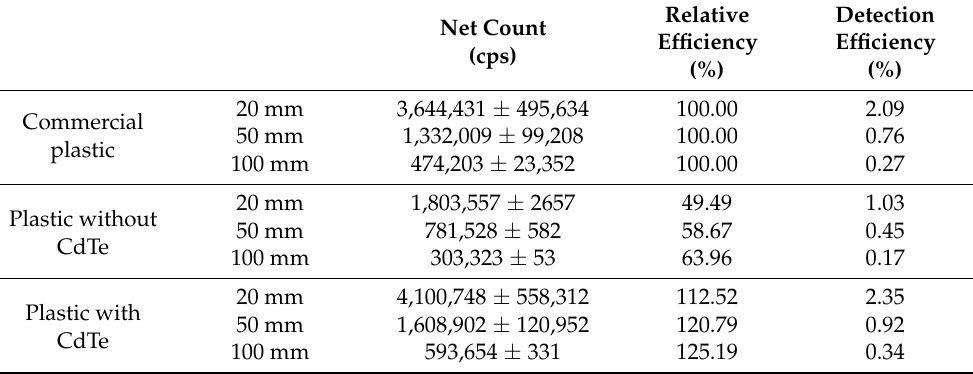
Table 2. Compared relative efficiency for detection of radioactive